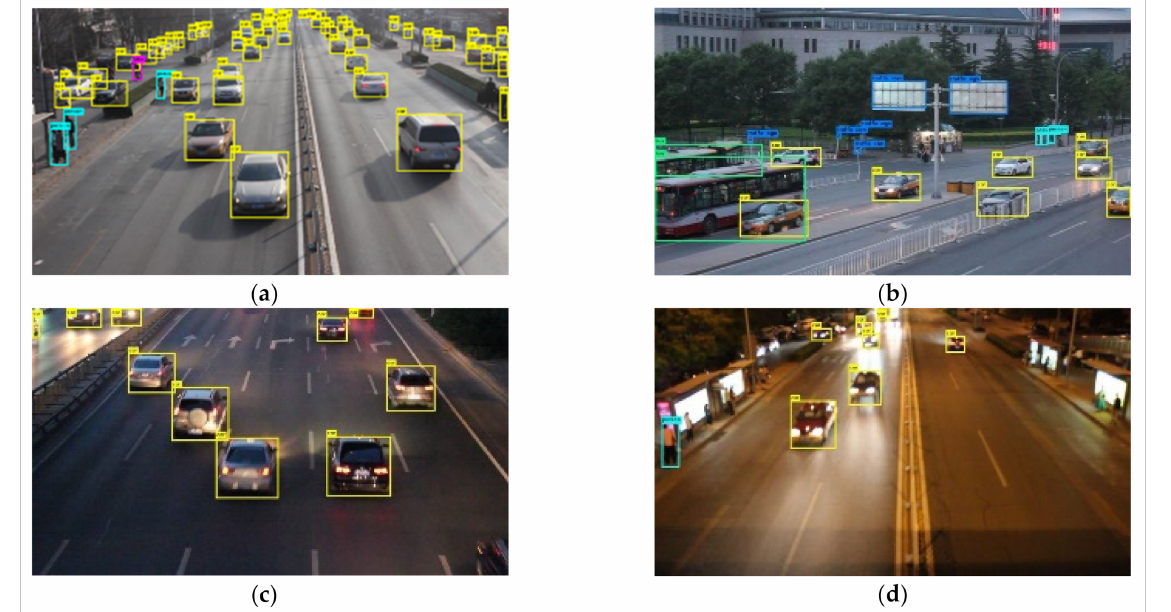
Figure 2. Partial test results for different scenarios of the UA-DETRAC dataset. ( a ) Sunny daytime; ( b ) cloudy evening; ( c ) night; ( d ) interference by strong light at